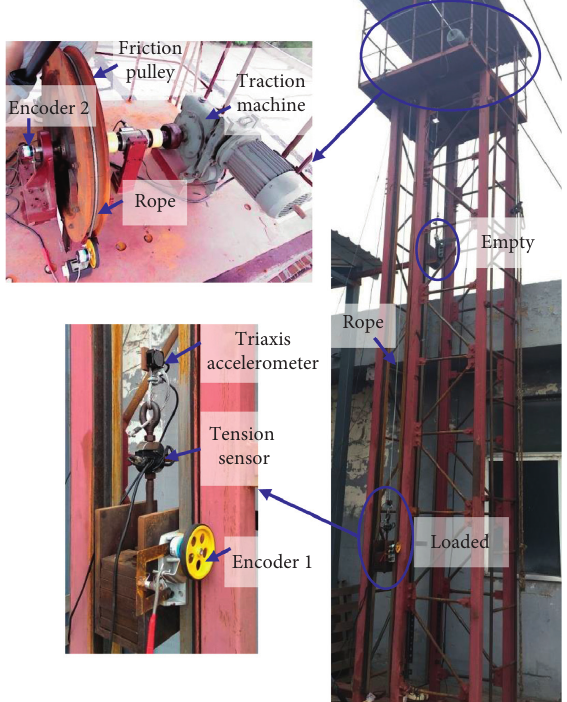
Figure 3: Photos of the dynamic friction transmission experiment